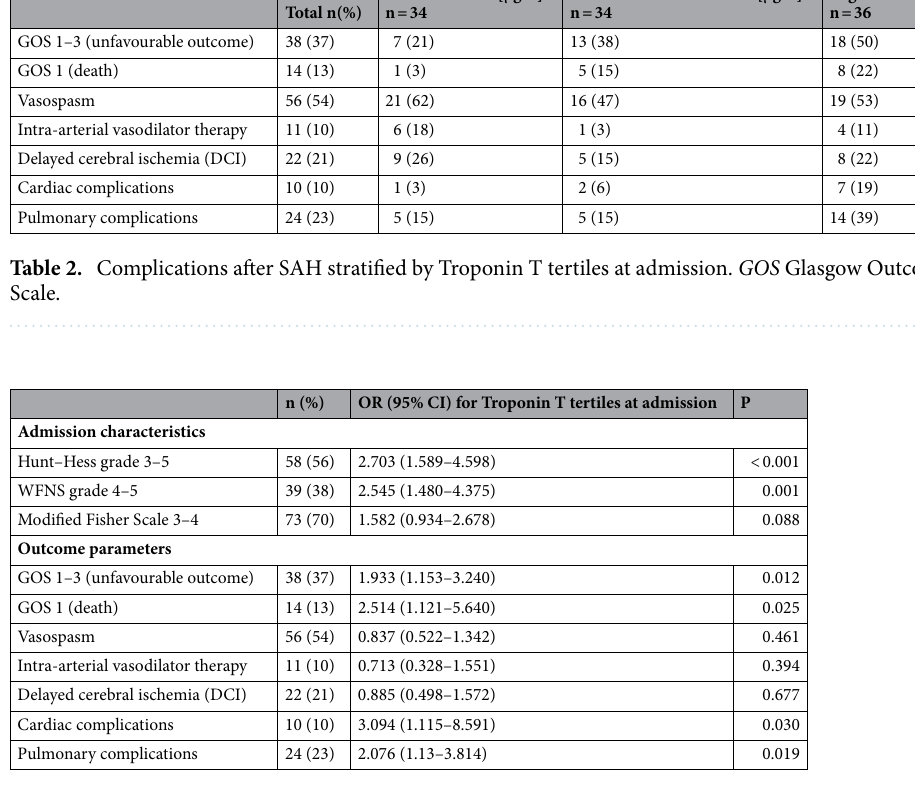
Table 3. Admission characteristics and outcomes associated with Troponin T. GOS Glasgow Outcome Scale.